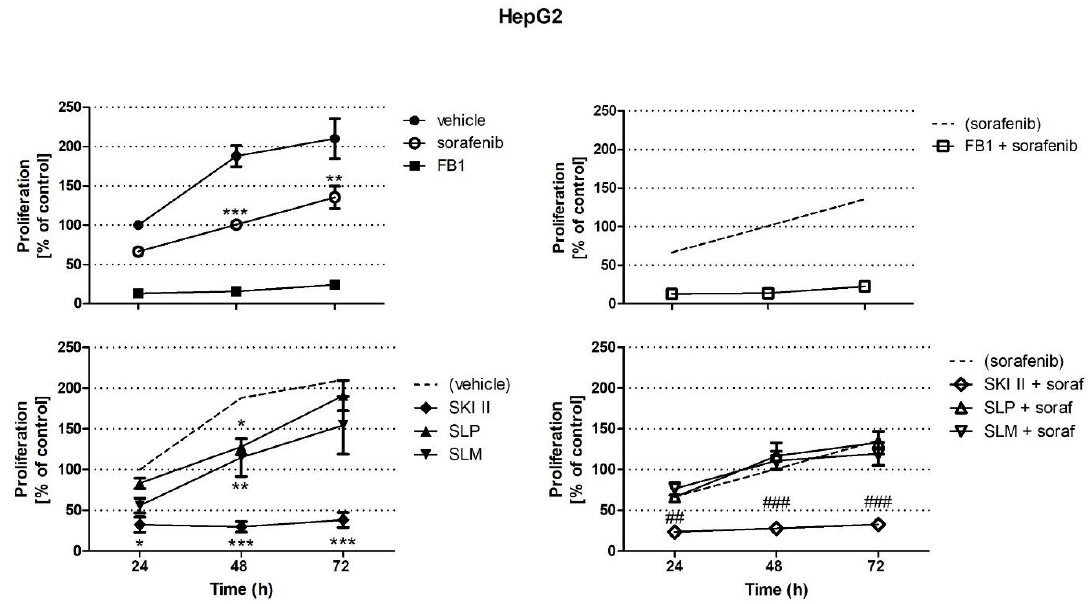
Figure 1. Influence of sorafenib, fumonisin B1 (FB1), and sphingosine kinase (SPHK) inhibitors on the proliferation of HepG2 cells. Cell proliferation was analyzed by measuring the incorporation of radioactively labeled thymidine. The cells were pretreated with 25 µ M of FB1 for 1 h, or with 10 µ M SKI II, 1 µ M SLP, or 1 µ M SLM for 2 h. Then, vehicle (control; 0.2 % DMSO) or 5 µ M sorafenib (soraf) were added for the indicated periods of time. All data are derived from three independent experiments performed in triplicate, which comprised all conditions; FB1 was included in two of these experiments. The dashed lines repeatedly indicate vehicle control or sorafenib as shown in the upper left panel. The values are means ± SEM and expressed relative to vehicle control at 24 h. * p < 0.05, ** p < 0.01, *** p < 0.001 compared to control; ## p < 0.01, ### p < 0.001 compared to sorafenib in two-way ANOVA ( n = 2 for FB1 and n = 3 for SK I II, selective SPHK2 inhibitor SLM6031434 (SLM), and SPHK1 inhibitor SLP7111228 (SLP)) .